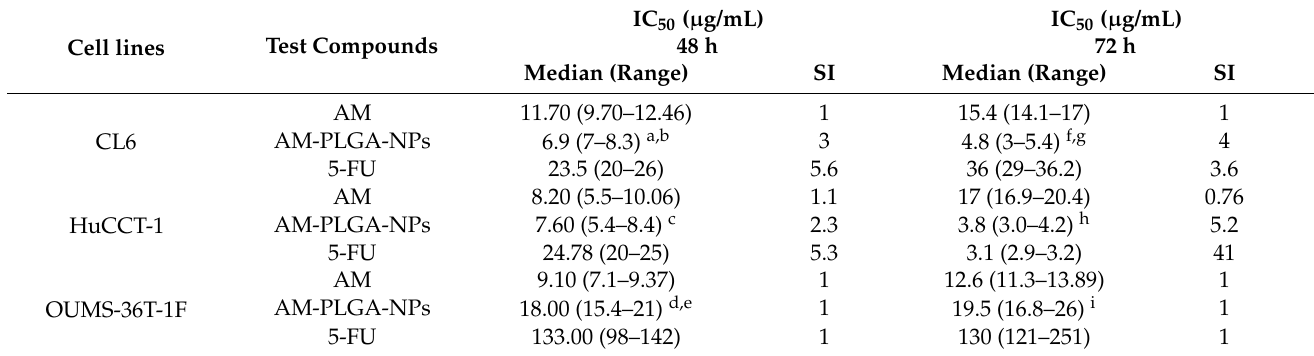
Table 2. Antiproliferative activities (IC 50 ) and the SI of free AM, AM-PLGA-NPs, and 5-FU on the CL-6, HuCCT-1, and OUMS-36T-1F cell lines after 48 h of exposure. Data presented as median (range) of triplicate